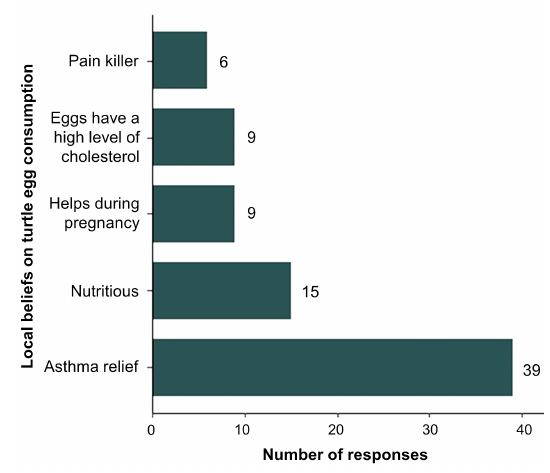
Fig. 4 . Traditional medicinal beliefs and other health effects associated with turtle egg